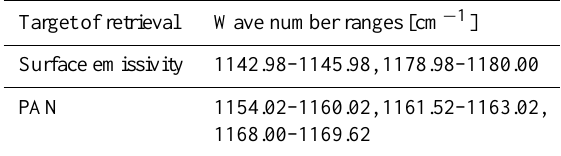
Table 1. Microwindows used in the TES PAN retrieval (and preced- ing emissivity retrieval